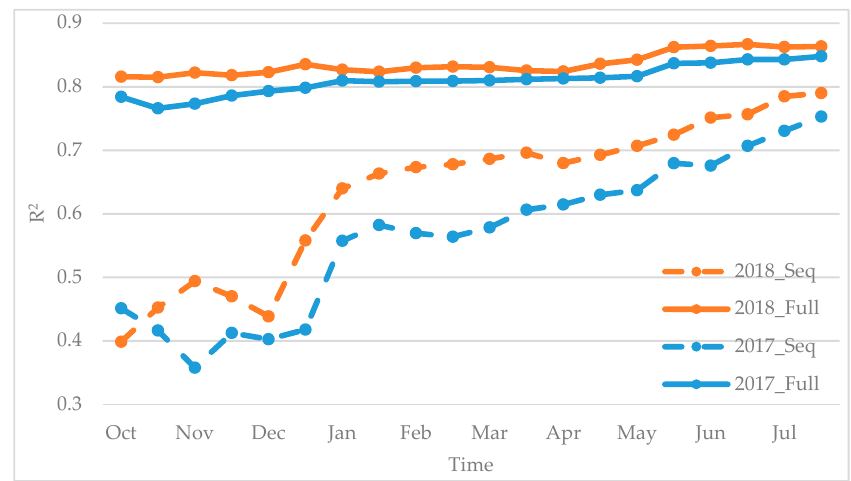
Figure 7. The time-series performance of the AdaBoost model (Seq: using sequential data; Full: using all data).